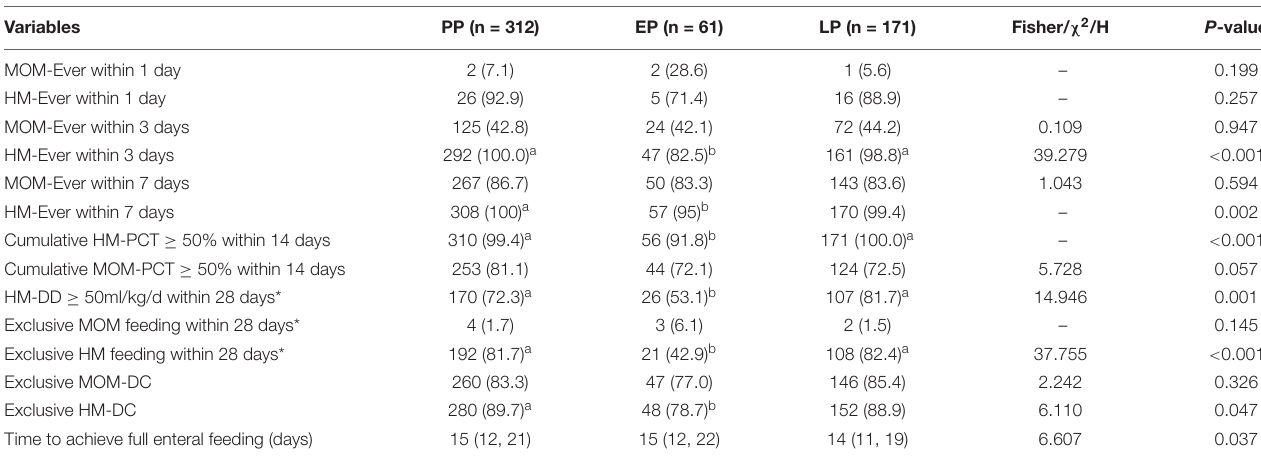
TABLE 5 | Comparison of categorical feeding indicators for preterm infants in NICU